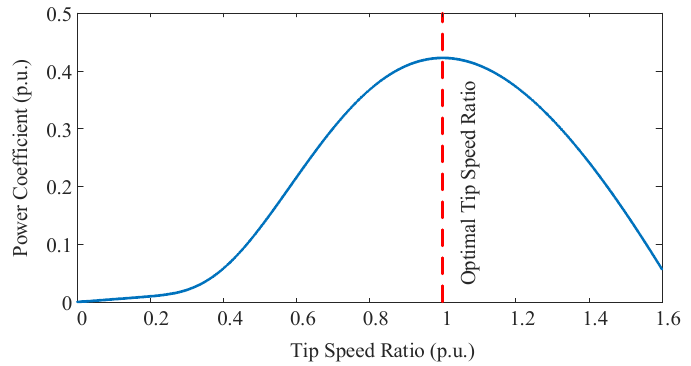
Figure 2. Power coefficient curve.